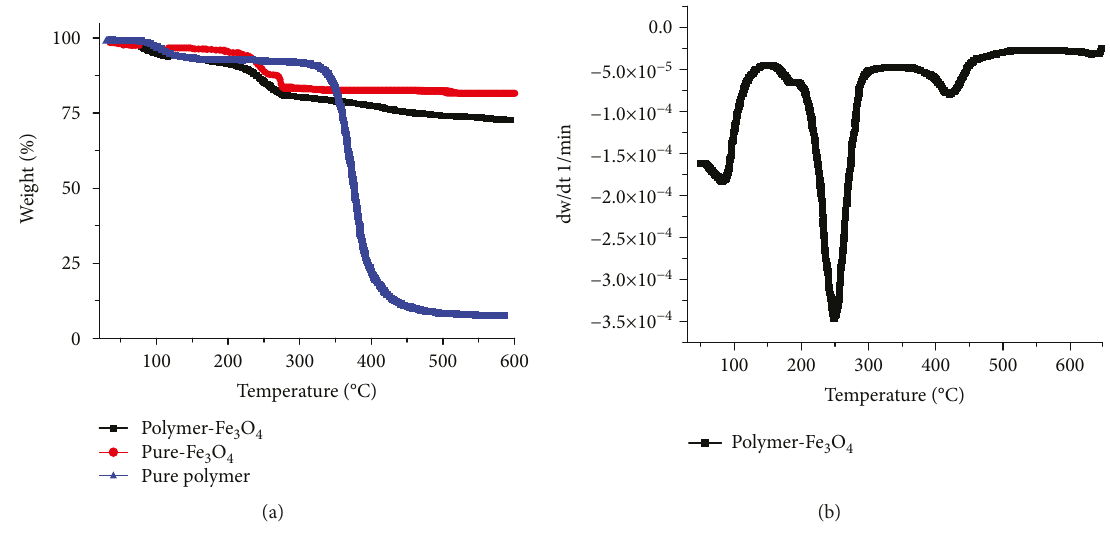
Figure 2: (a) TGA and (b) DTG analysis of the fi nal polymer composite with that of pure polymer and pure iron oxide. Table 1: TGA and DTG of surface modi fi cation of the polymer. Pyrolysis temperature Weight loss 86.53 °